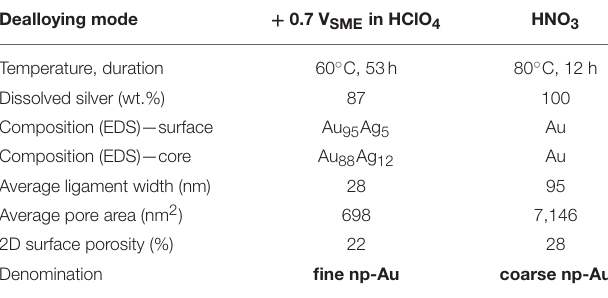
TABLE 1 | Characteristics of np-Au obtained by electrochemical and chemical dealloying. Dealloying mode + 0.7 V SME in HClO 4 HNO 3 Temperature, duration 60 ◦ C, 53h 80 ◦ C, 12 h Dissolved silver (wt.%) 87